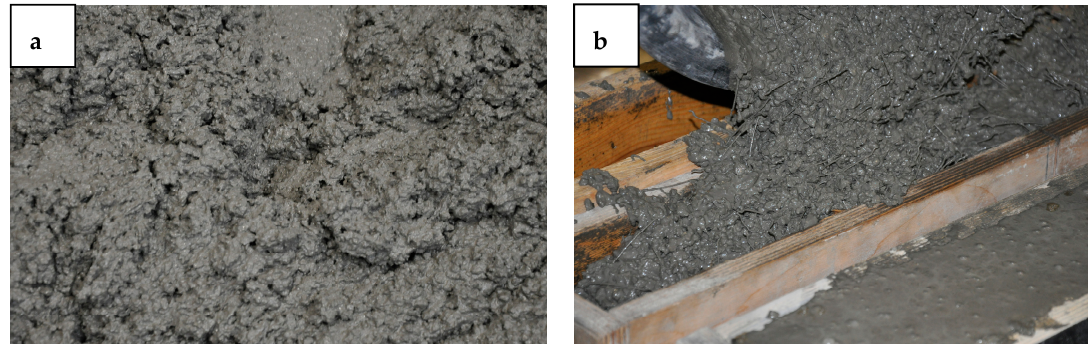
Figure 4. Appearance of fresh mixtures ( a ) high-performance concrete (HPC) and ( b ) hybrid steel-polypropylene fibre-reinforced high-performance concrete (HFRHPC).